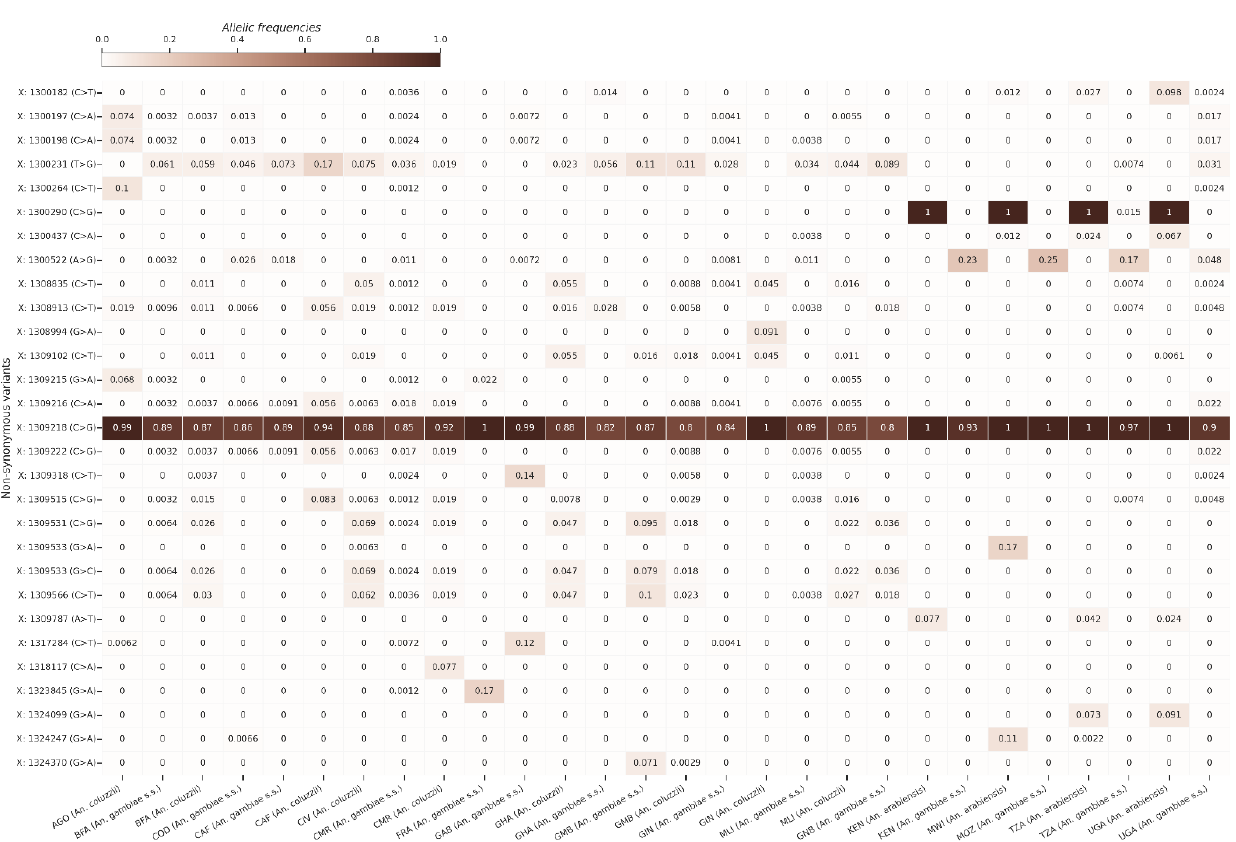
Figure 1. Heat map showing the allelic frequencies of the non-synonymous mutations with maximum allelic frequencies that are > 5% in at least one population. The vertical axis of the heat map shows the non-synonymous variant positions in the X chromosome, and the horizontal axis shows the populations of An. gambiae s.l. The gradient color bar shows the distribution of the allelic frequencies. AGO : Angola; BFA : Burkina Faso; CAF : Central African Republic; CIV : Côte d’Ivoire; CMR: Cameroon; COD: Democratic Republic of Congo; FRA: Mayotte; GAB: Gabon; GHA: